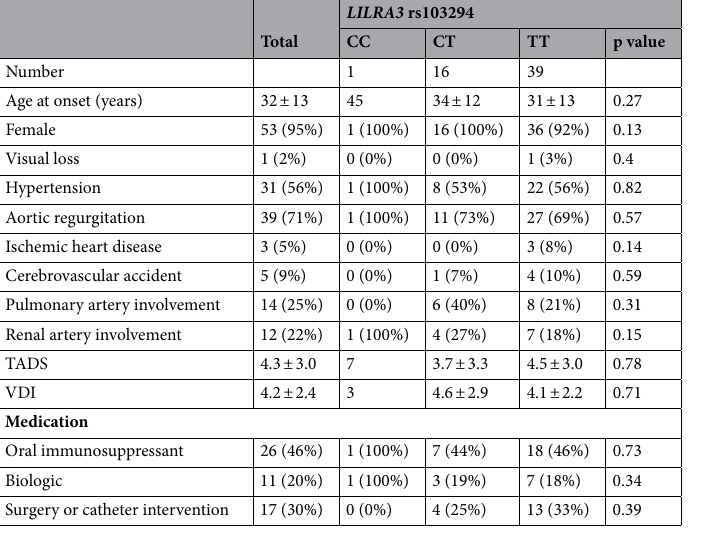
Table 3. Clinical characteristics of HLA-B52-positive patients stratified by LILRA3 genotypes. TADS Takayasu arteritis damage score, VDI vasculitis damage index. Data are n (%) or mean ± standard